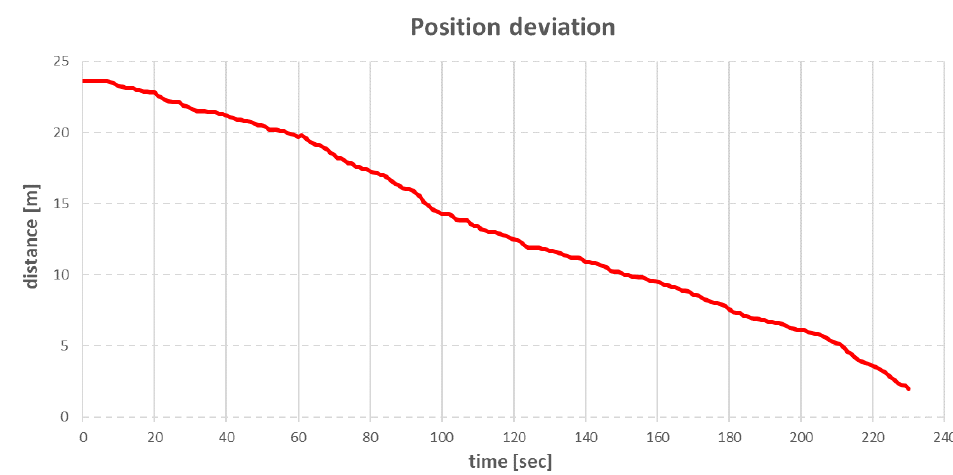
Figure 31. The ship ’ s position deviation after changing target position. The movement of the vessel started 8 s after the anchor rope lengths were recalculated. The anchor winches that pulled in the rope achieved this with a constant step of 0.1 m/s. vessel stopped approximately 2 m from the target point, when the anchor winches stopped working. The changes in the individual anchor rope lengths during the move are shown in Figure 32.